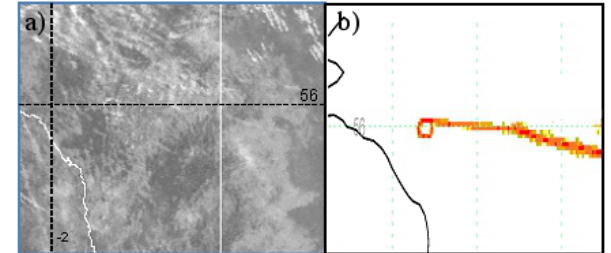
Fig. 11. (a) Satellite image (10.8–12.0µm product from NOAA 16, overpass 18:23UTC) from Flight B587, the North-East coast of England can be seen to the left of the image. 2. (b) the simulated contrail from the NAME simulations at 18:23UTC.